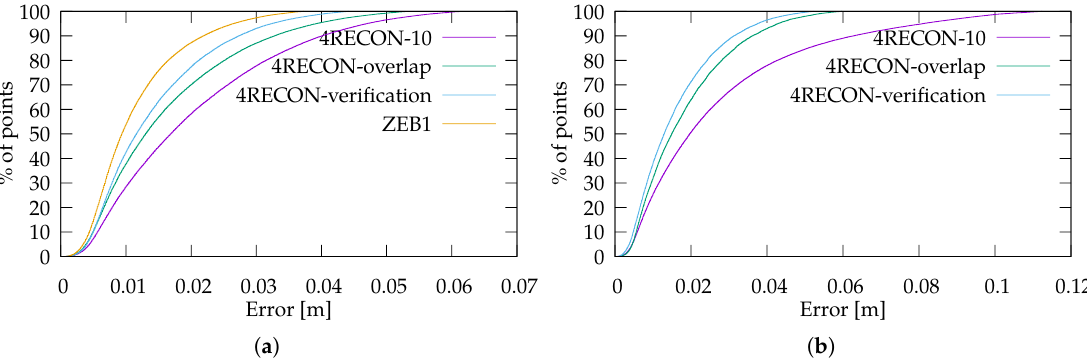
Figure 21. Error e r distribution (the amount of the points within certain error) for our system 4RECON and ZEB-1 product. The experiments were performed for all test slices in Figure 20 on Office ( a ) and Staircase ( b ) dataset. Note that the model built by ZEB-1 was not available and therefore the evaluation is